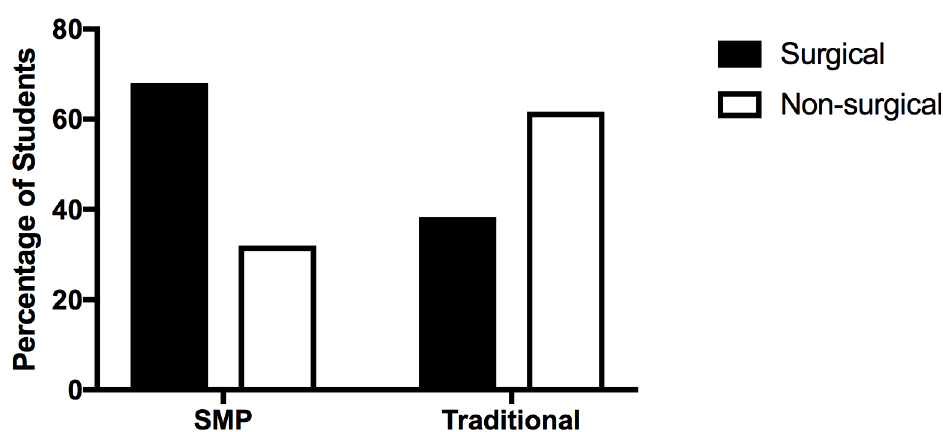
Fig 5. Comparative analysis of residency distribution between SMP and traditional students. 72 of the total 130 respondentsreportedbeing in a residencyprogram. 25 were SMP-students and 47 were traditional students. Residencyprograms were classified into two categories: surgicalsubspecialties and non-surgical subspecialties. The surgicalsubspecialtycategory is comprisedof orthopedicsurgery, plastic surgery, generalsurgery, urology, obstetrics and gynecology,anesthesiology, and emergency medicine.The non- surgicalsubspecialtycategory is comprisedof family medicine,pediatrics,pathology,internalmedicine, psychiatry, radiology,neurology, and physicalmedicineand rehabilitation. Of the SMP respondents17 (68%) were acceptedinto surgical subspecialties whereas8 (32%) were acceptedinto non-surgical subspecialties. Of the traditional respondents 18 (38.3%) were acceptedinto surgicalsubspecialties and 29 (61.7%) were acceptedinto non-surgical subspecialties. Chi-squaredanalysisrevealedthis difference in distributionto be significant(p <